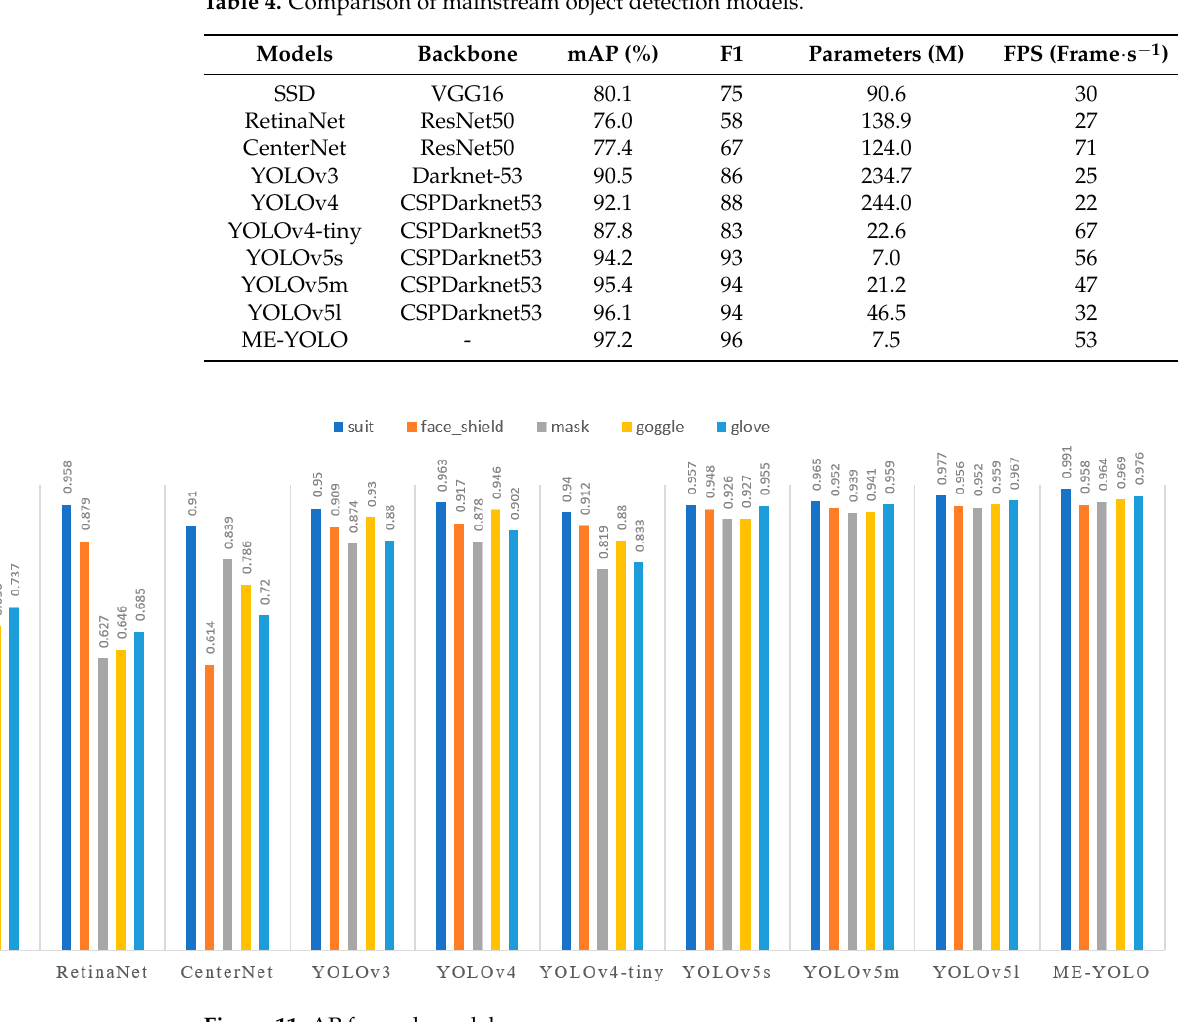
Table 5. Comparison of different models in FPS.